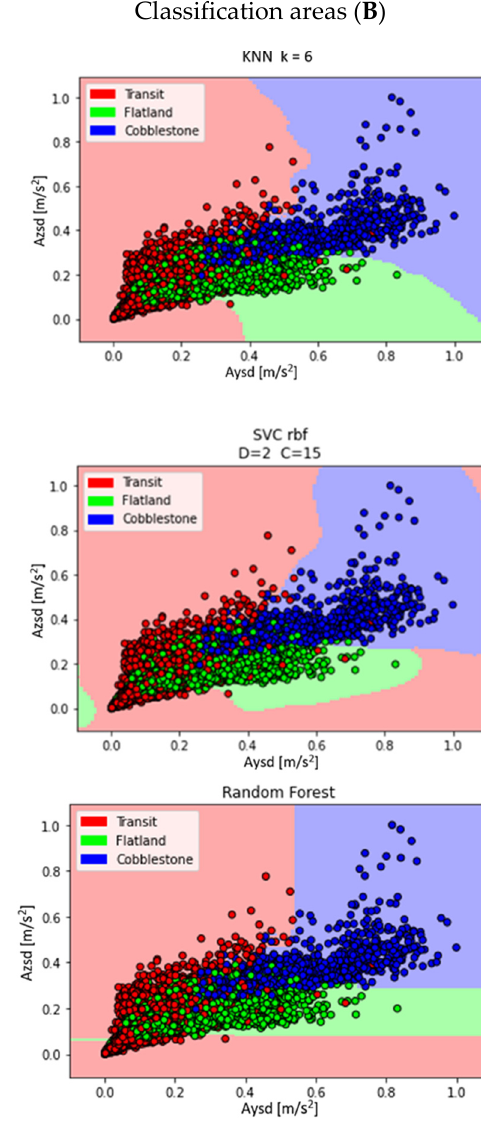
Figure 13. ( A ) Confusion matrices for KNN, SVM:RBF, and RF. ( B ) Class zones examples created by each classifier for two dimensions.